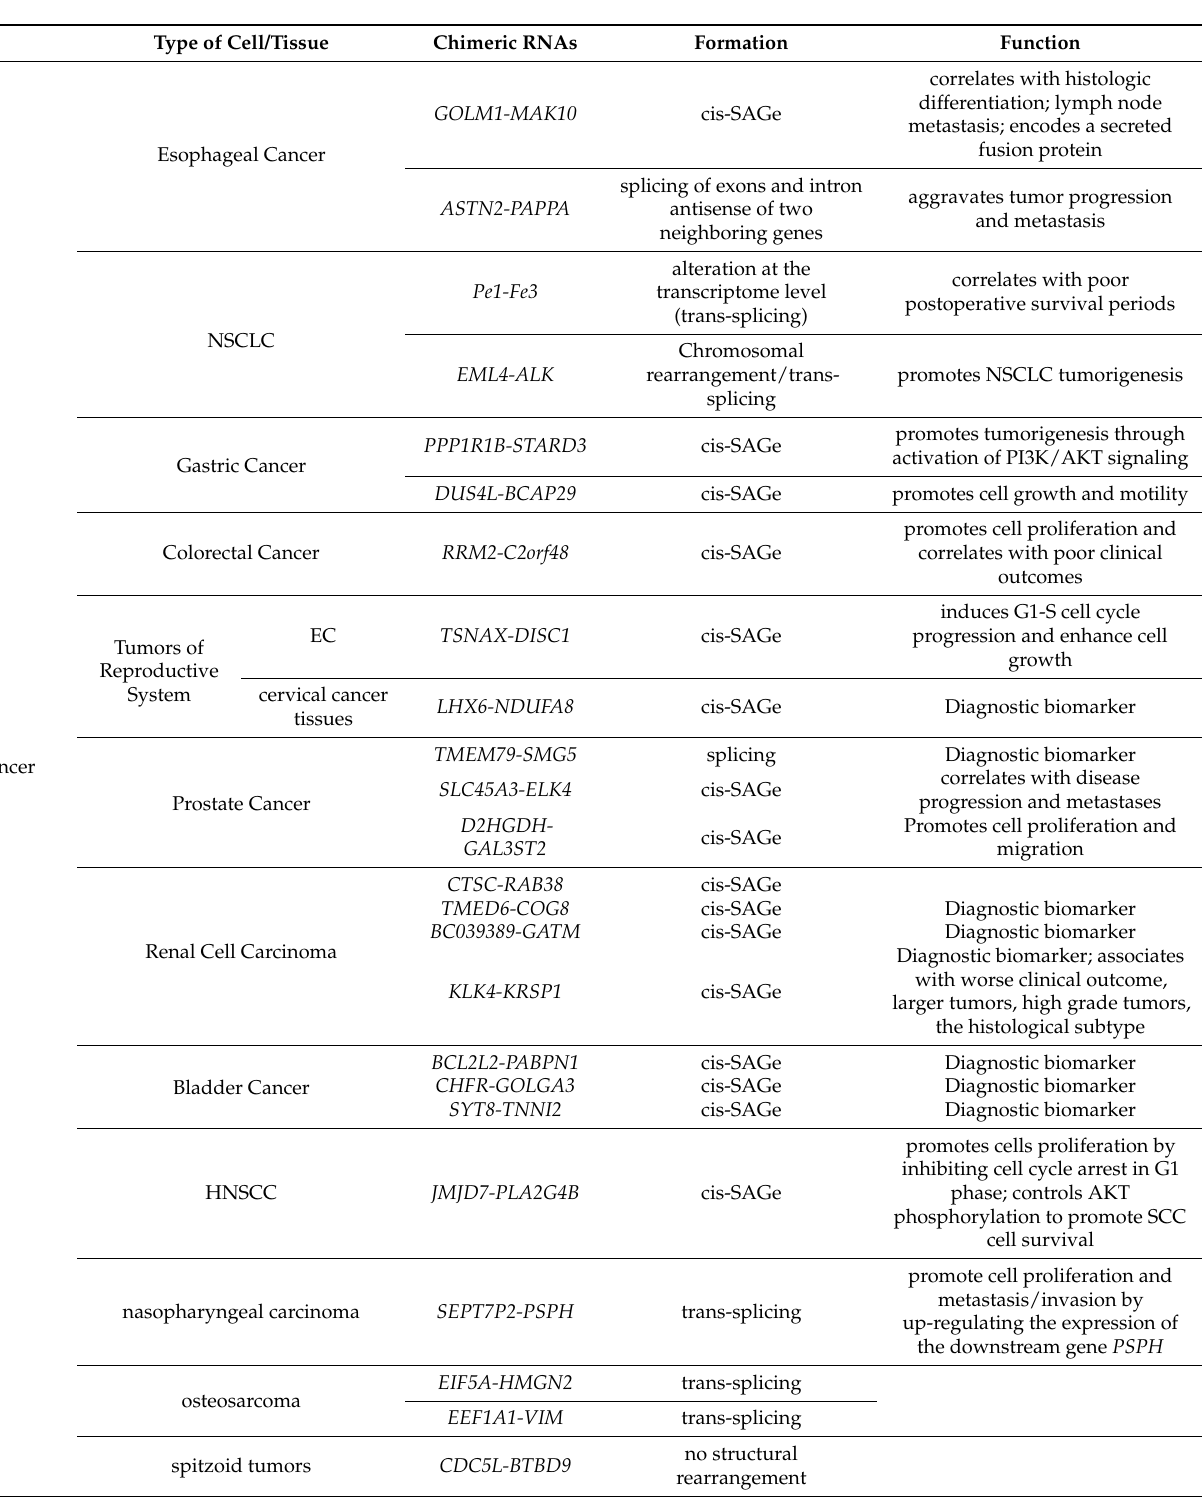
Table 1. The roles of chimeric RNAs generated by different mechanisms in different types of cancer and normal